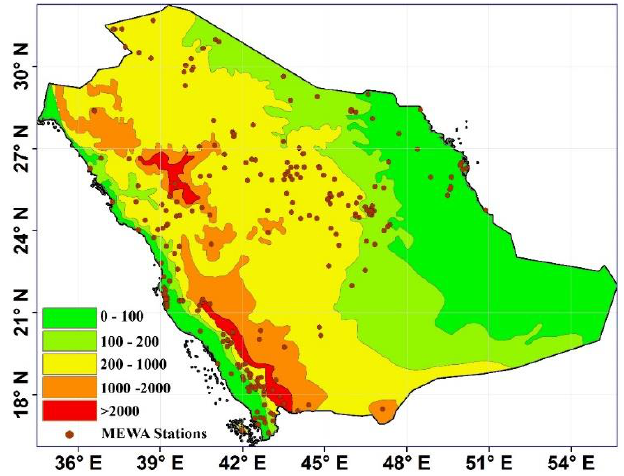
Figure 3. Distribution of rain gauges over the different topographical regions in Saudi Arabia (alti-